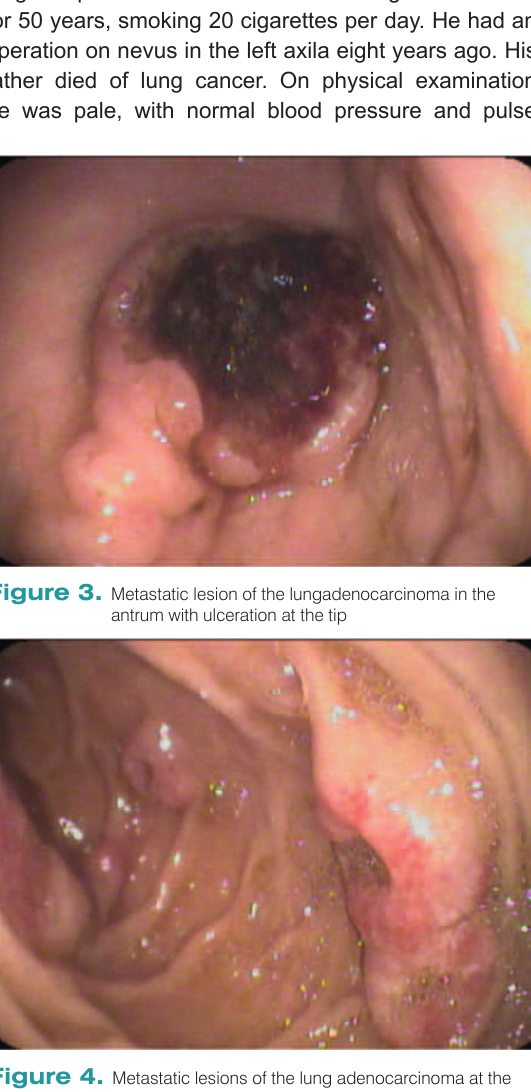
Figure 2. Malignant melanoma metastases in the stomach with abundant melanin pigment (H.E.)